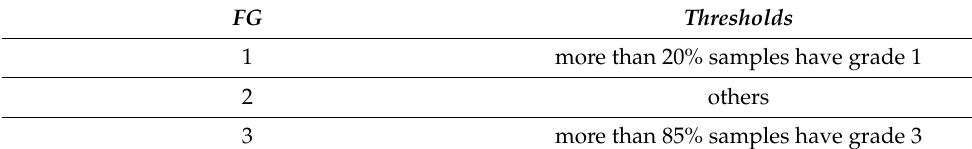
Table 6. Thresholds for the final performance grade FG .